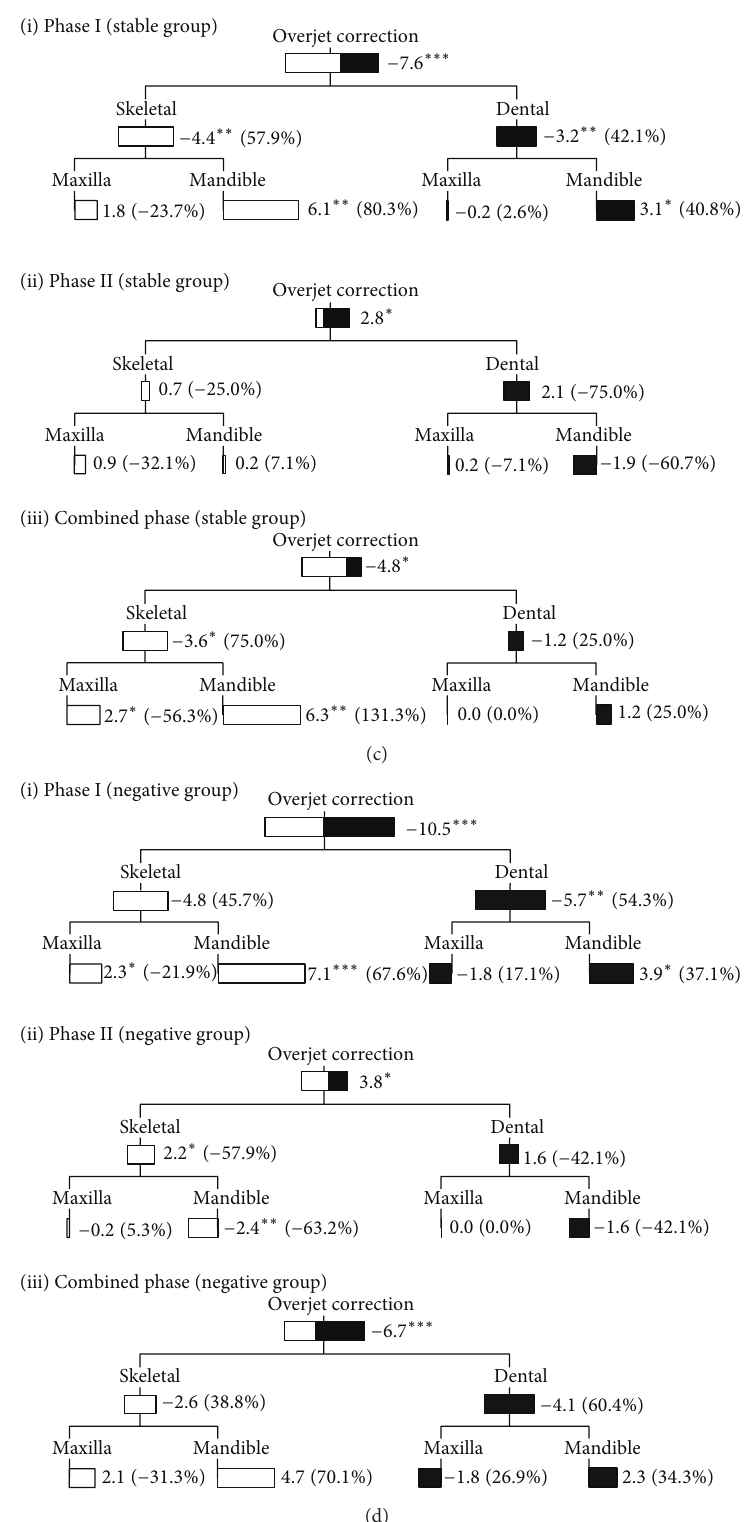
Figure 2: Overjet correction of (a) the whole study sample, (b) positive group, (c) stable group, and (d) negative group for phase I (T0-T1), phase II (T1-T2), and the total treatment period (T0–T2) ( ∗ 𝑃 < 0.05 ; ∗∗ 𝑃 < 0.01 ; ∗∗∗ 𝑃 < 0.001